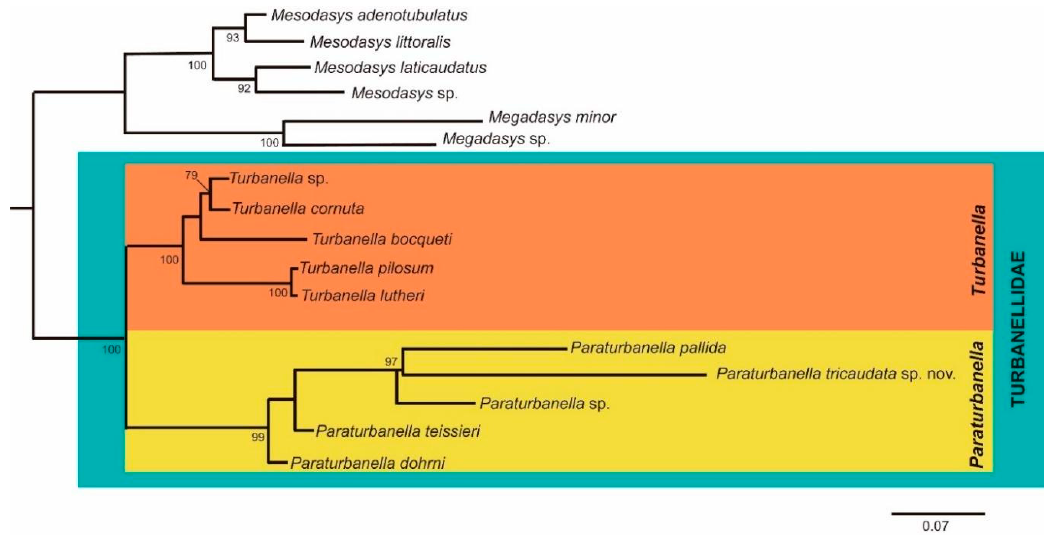
Figure 8. Phylogenetic relationships of Turbanellidae species inferred from Maximum Likelihood analysis of 18S and 28S rRNA. Numbers at nodes represent bootstrap support (1000 bootstrap replicates).